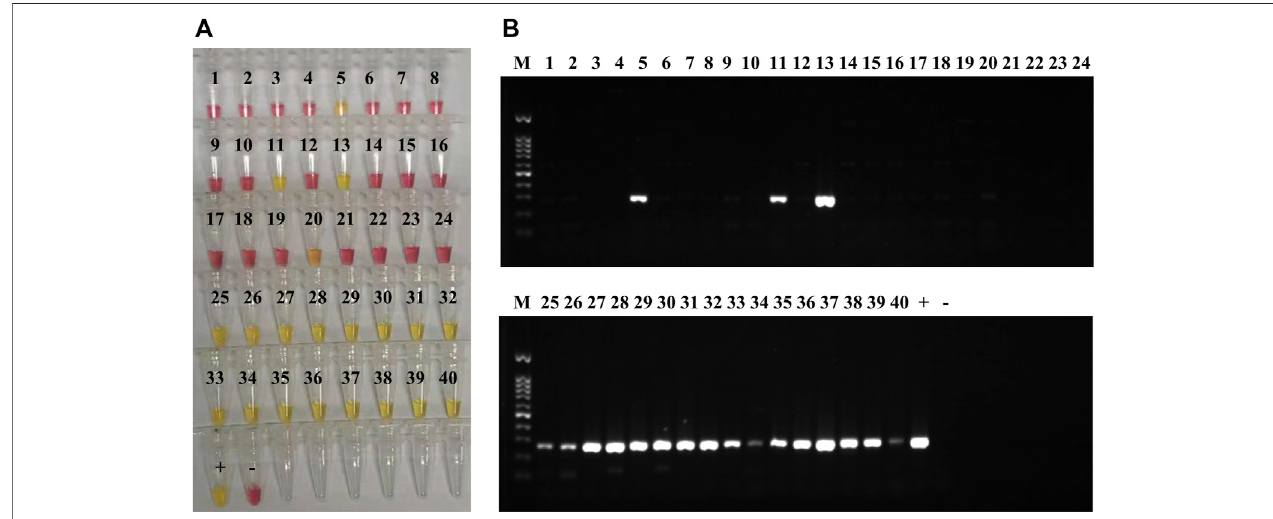
FIGURE 4 | K. pneumoniae LAMP and PCR detection in clinical sputum samples. (A) Colorimetric LAMP results, targeting the yhaI gene, obtained on DNA extracted from 40 clinical sputum samples; 20 of the samples were positive (yellow; 5, 11, 13, 20, and 25 – 40), and 20 were negative (pink; 1 – 4, 6 – 10, 12, 14 – 19,